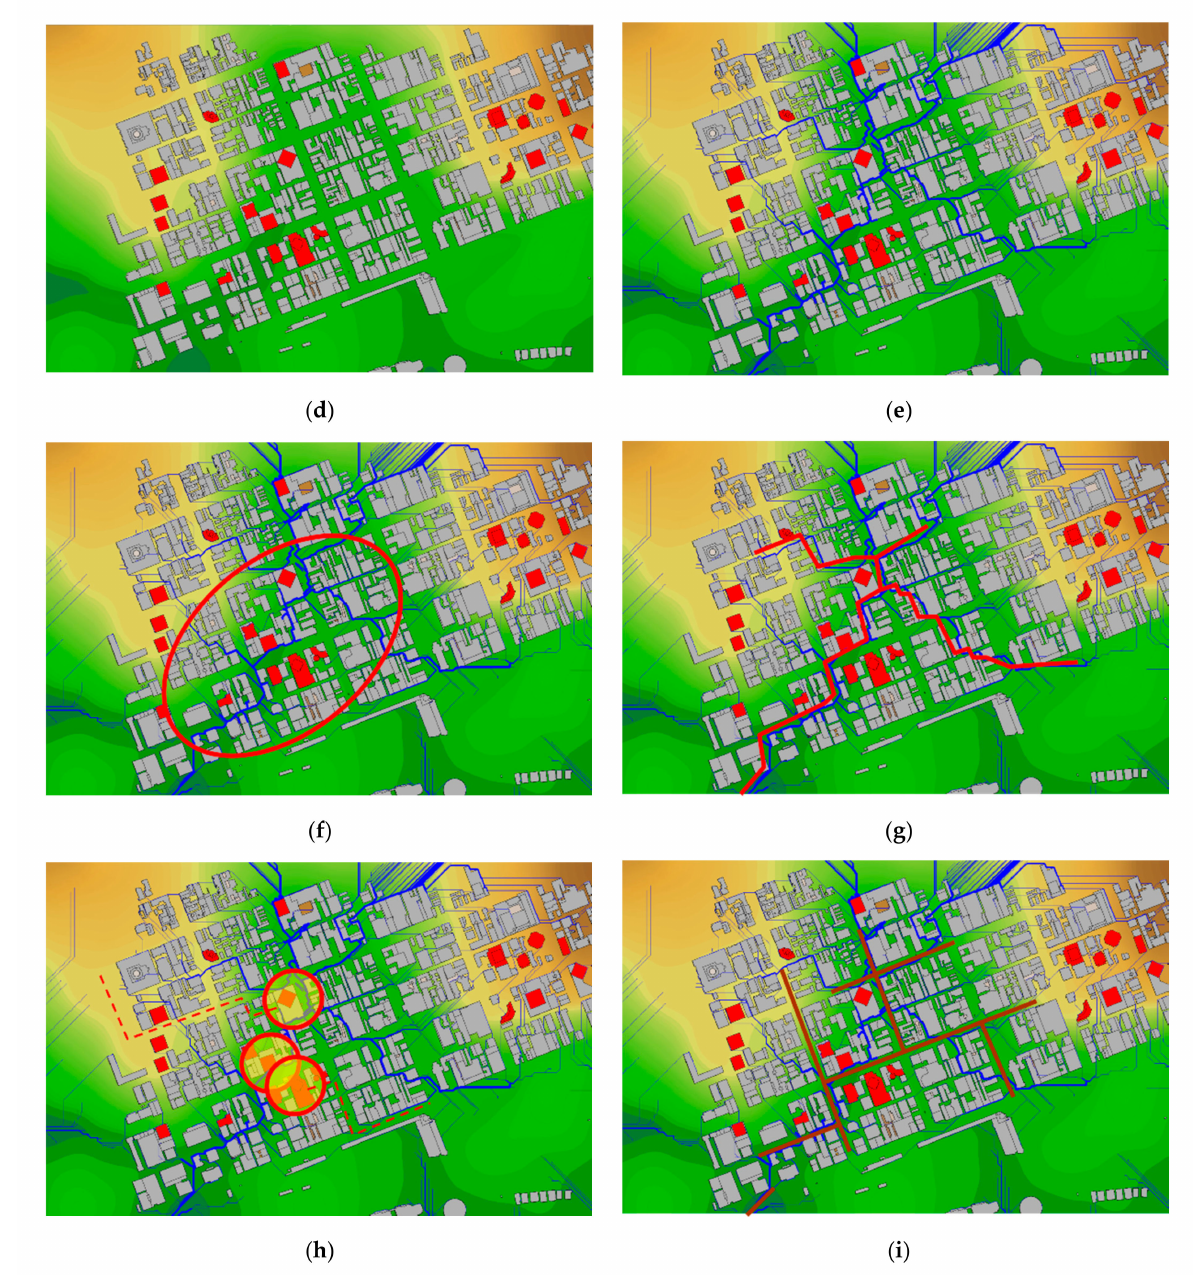
Figure 3. Modeling the threat of local flooding (Encom MapInfo Discover) 2D model. ( a ) Creation of a numerical terrain model for the flooded area. ( b ) Numerical terrain model for an urbanized area. ( c ) Creation of a flood model. ( d ) Selection of residential buildings in the endangered area. ( e ) Determination of places where water accumulates during flooding. ( f ) Designation of zones particularly threatened by flooding. ( g ) Selection of streets that will be “cut off” during flooding. ( h ) Identification of residential buildings particularly vulnerable to flooding and designation of pathways for access and evacuation during flooding. ( i ) Planned sewerage network, discharging excessive